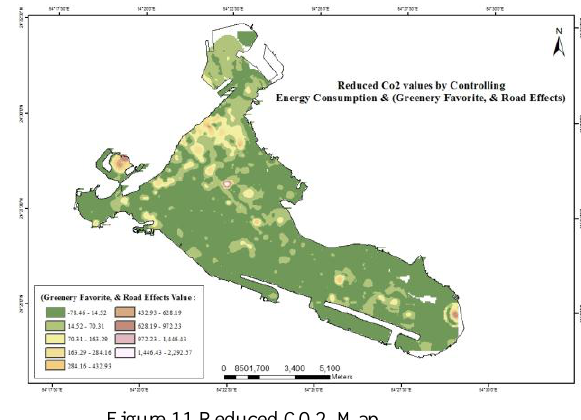
Figure 11 Reduced CO2 Map (Energy reduction + Green factor - Road